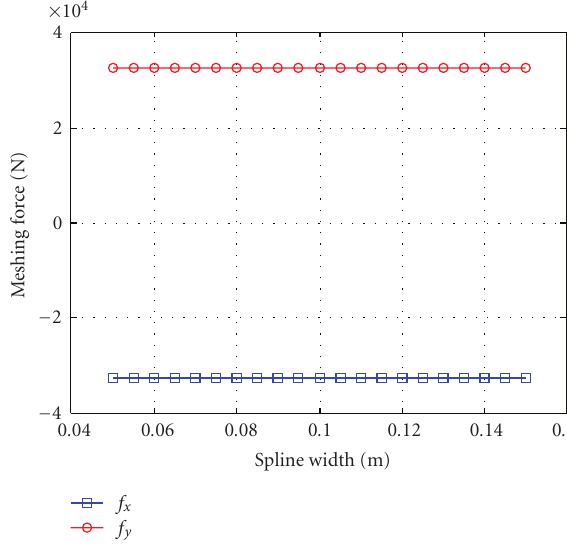
Figure 7: Meshing force versus AMD.